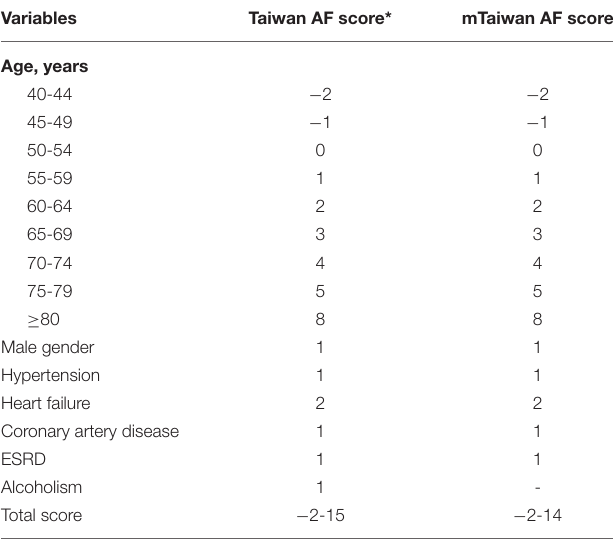
TABLE 1 | Calculations of Taiwan AF score and modified Taiwan AF score.